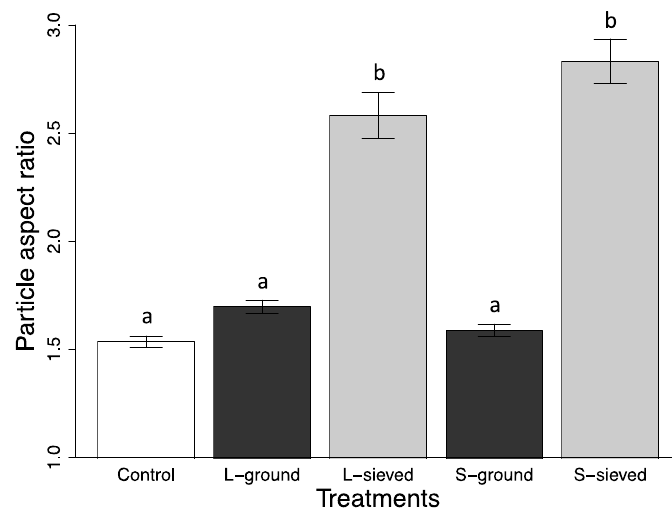
Figure 3. Aspect ratio of biochar particles by treatment and of sand (control) particles. Means are plotted ± 1 standard error based on 277 particles detected by flatbed scanner for each treatment. Bars with the same lower case letters do not differ significantly at p < 0.05 according to Tukey’s honest significant difference (HSD) test.